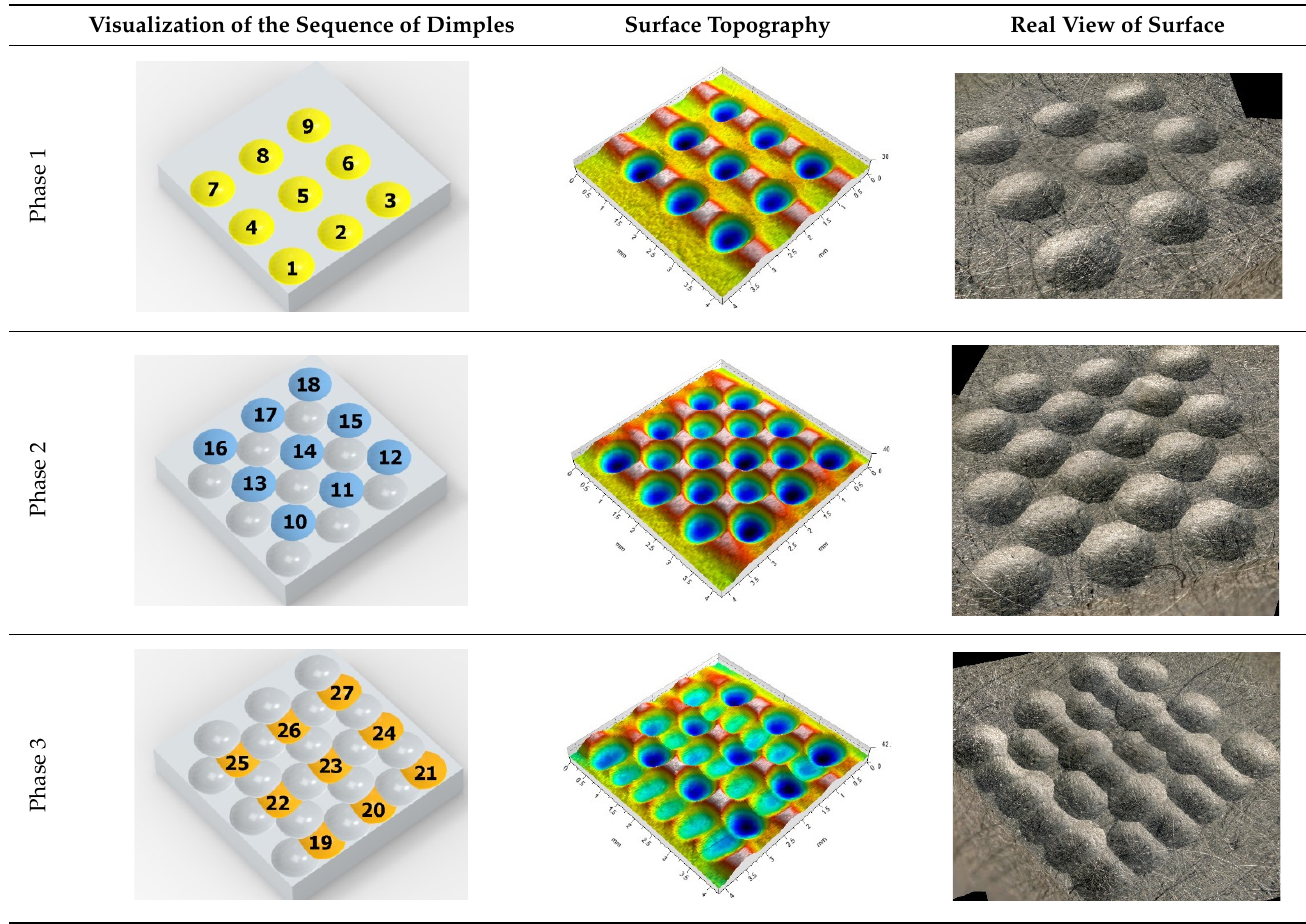
Table 2. Methodology of exerting a sequence of impacts in semi-random shot peening (SRSP). Visualization of the Sequence of Dimples